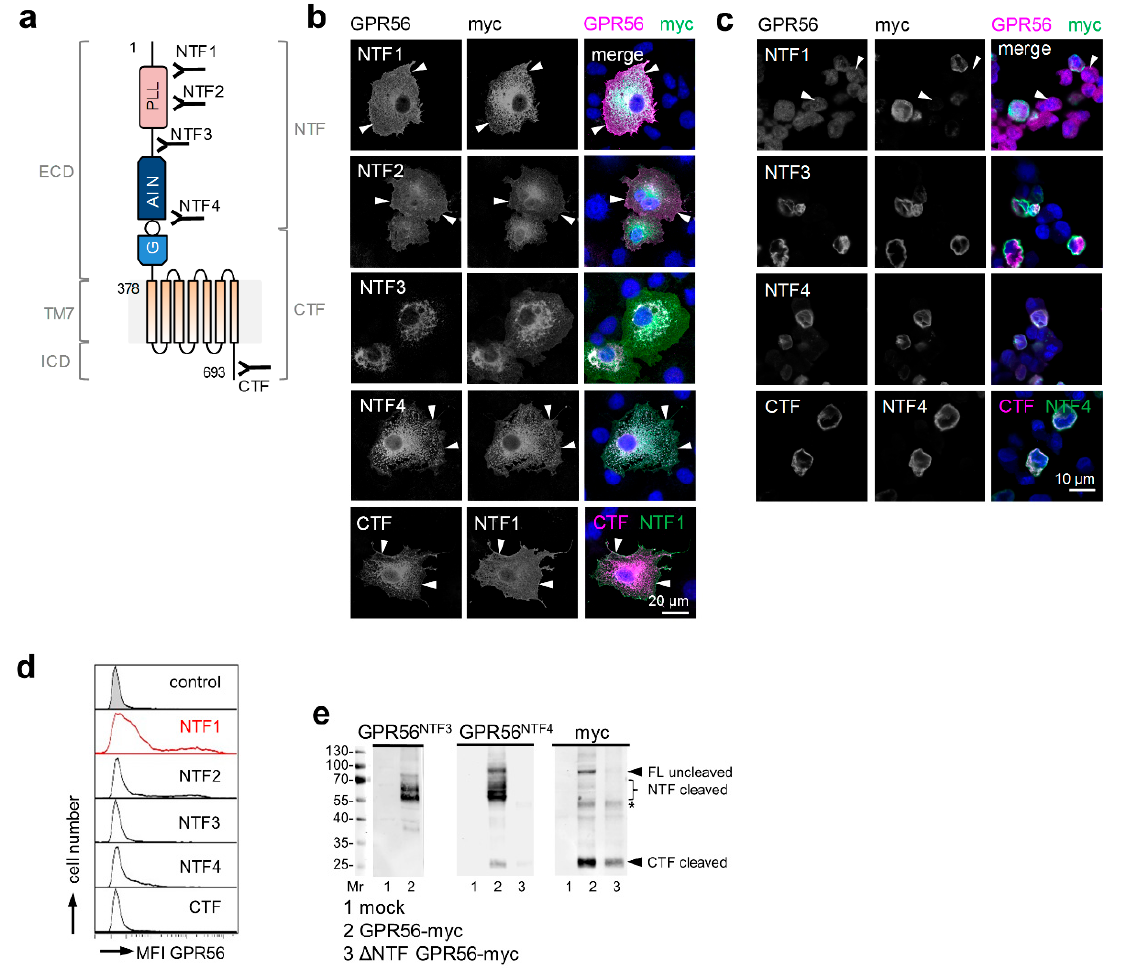
Figure 1. Verification of GPR56 Abs using tagged GPR56. ( a ) Schema of GPR56 and GPR56 Ab binding sites; see running text for explanations. ( b – e ) COS-7 cells, transfected with C-terminal myc-tagged or untagged full-length (FL) ADGRG1 (NM_201524.3), or ∆ NTF ADGRG1 pcDNA3.1 were used to examine GPR56 Ab specificity. ( b ) Monolayered, acetone-fixed GPR56myc cells were costained for GPR56 and myc. All GPR56 Abs bound GPR56 specifically (arrows: membrane-near staining); immunofluorescence. The GPR56 CTF Ab binds only the untagged GPR56 C-terminus, therefore, cells transfected with untagged ADGRG1 were co-stained with the well-established GPR56 NTF1 Ab. ( c ) GPR56myc cells were detached and paraffin-embedded. Sections were costained with the indicated Abs (see also ( b )); immunofluorescence. The GPR56 NTF1 Ab unspecifically stained myc-negative cells (arrows). ( d ) Flow cytometry: GPR56myc Cos-7 cells were analyzed for GPR56 cell surface expression; MFI: mean fluorescence intensity. ( e ) Western blotting: lysates of mock, full-length (FL) GPR56myc or Δ NTF GPR56myc cells were blotted and the indicated Abs applied. The GPR56 NTF4 Ab bound to uncleaved GPR56 (~86.5 kDa), the cleaved NTF (56.6–60.5 kDa multiple bands), and, inconstantly and weakly, the CTF (~26 kDa). The myc Ab confirmed the results; * likely unspecific bands.